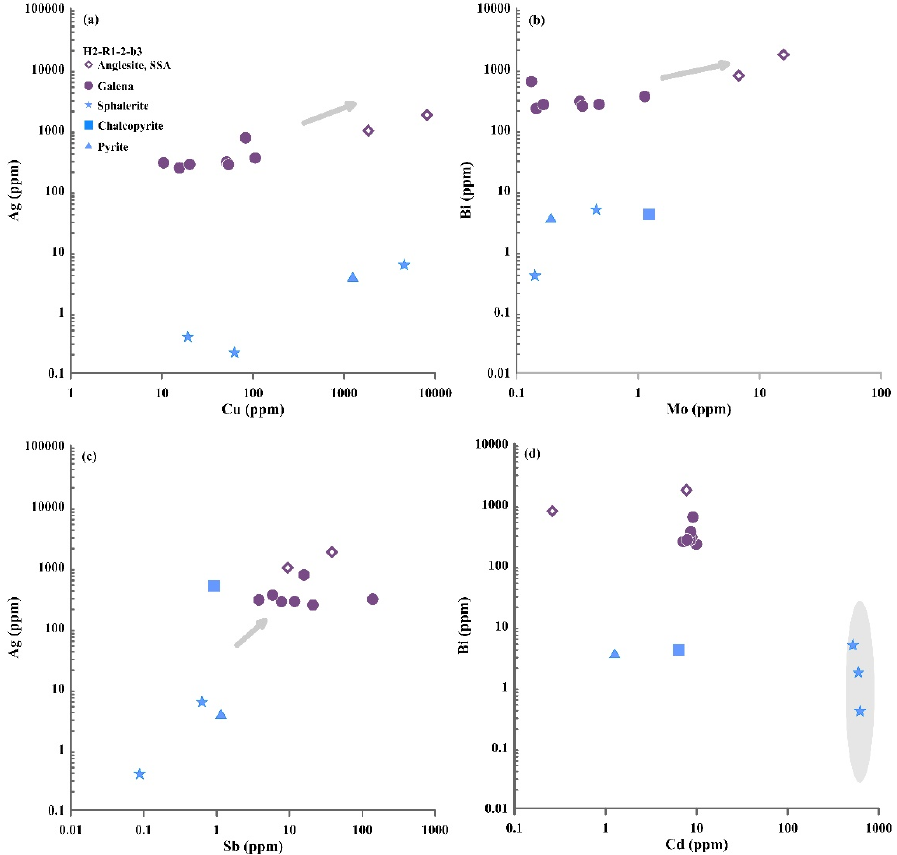
Figure 7. Plots of anglesite and sulfide minerals in sample H2-R1-2-b3: ( a ) Ag vs. Cu; ( b ) Bi vs.